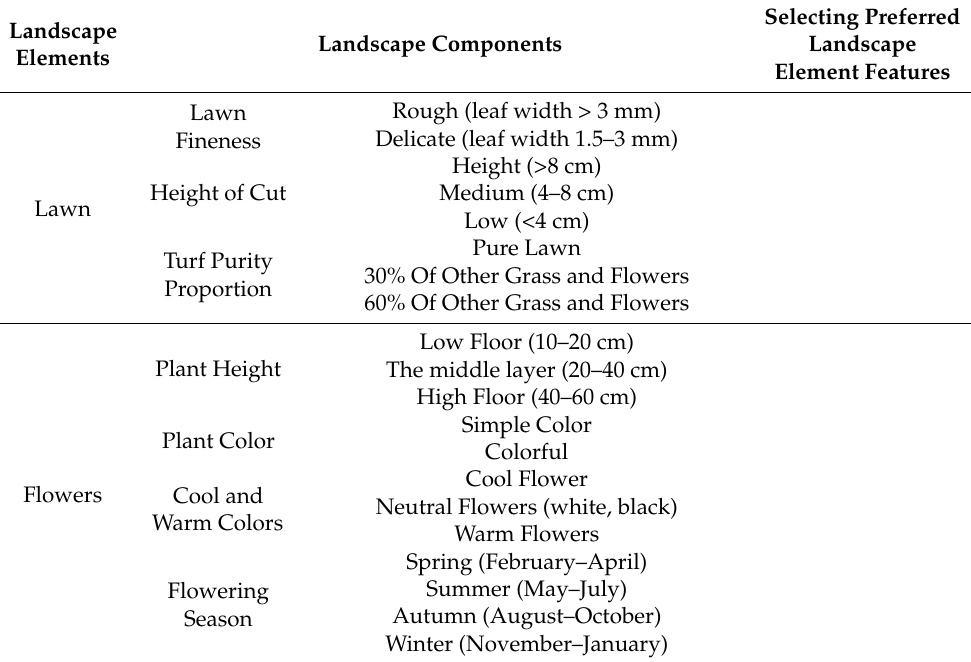
Table A3. Campus Landscape Preference Factor Scales of the ginkgo